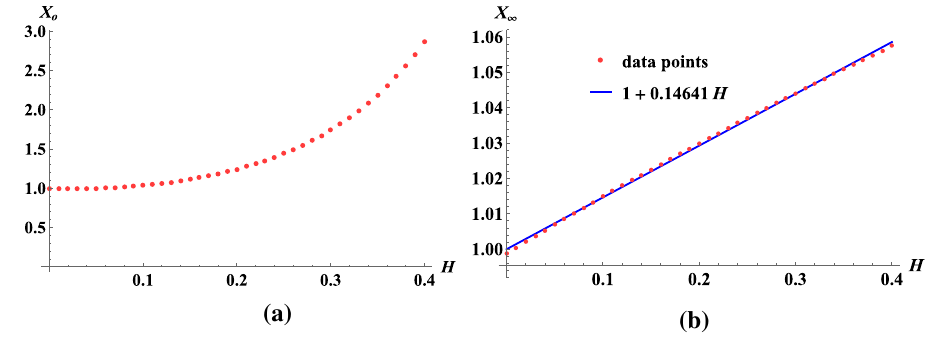
Fig. 5 The shadow length along the equatorial plane X o for an observer located at finite distance in a , and X ∞ for a distant observer in b . The parameter X o shows a nonlinear relation with respect to H . While H − X ∞ fits nicely